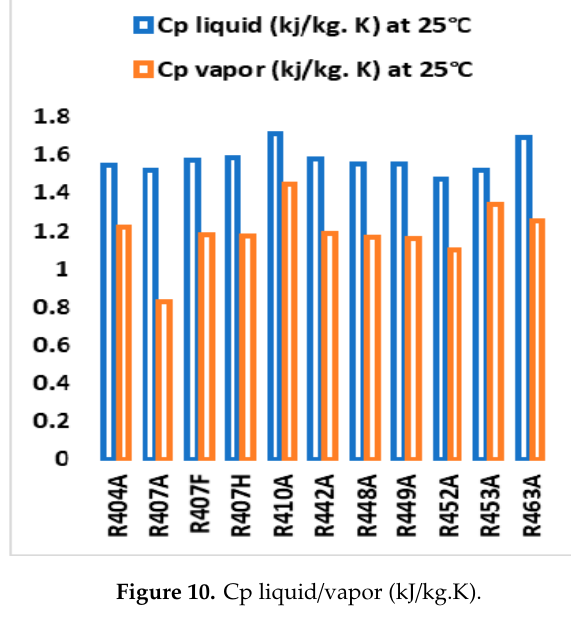
Figure 10. Cp liquid/vapor (kJ/kg.K).